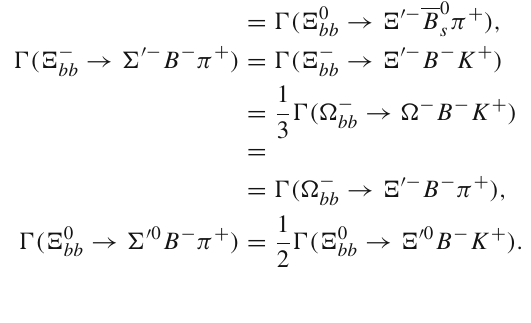
A.9: (cid:2) bb and (cid:5) bb decays into a bottom meson, a light decuplet baryon and a light